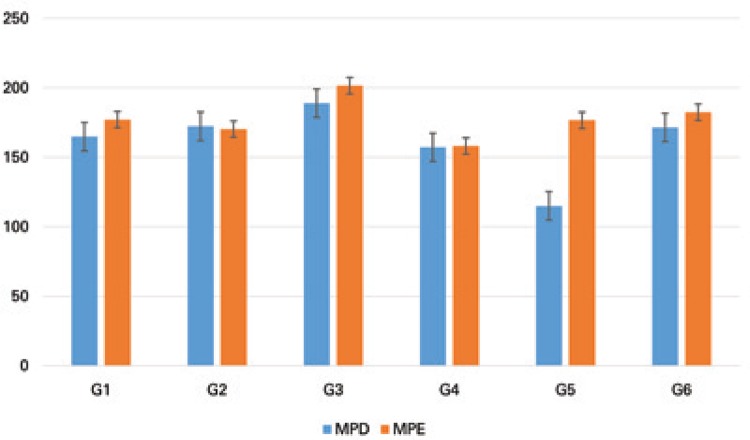
Espessura da placa epifisária da tíbia, comparando-se as ratas distribuídas entre os grupos de estudo (G1, G2, G3, G4, G5 e G6) e os membros posteriores direito (alvo) e esquerdo (controle). Letras iguais significam semelhanças e letras diferentes significam diferenças significativas entre os grupos experimentais, para o mesmo lado